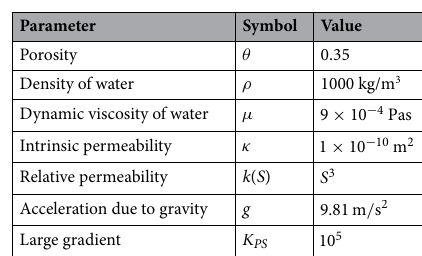
Figure 4. Left panel: Convergence of the moisture profile at t 0.01 , i 0, . . . , N and constant top boundary flux q 0 S i , in = = is set to zero. Each colour corresponds to a particular grid block size. The moisture profile converges and retains the overshoot pattern. Right panel: Convergence of the moisture profile at t 0.14 , i 0, . . . , N and constant top boundary flux q 0 for initial saturation S i , in = = of the bottom block is set to zero. Each colour corresponds to a particular grid block size. The moisture profile converges to a sharp water-front without saturation overshoot.